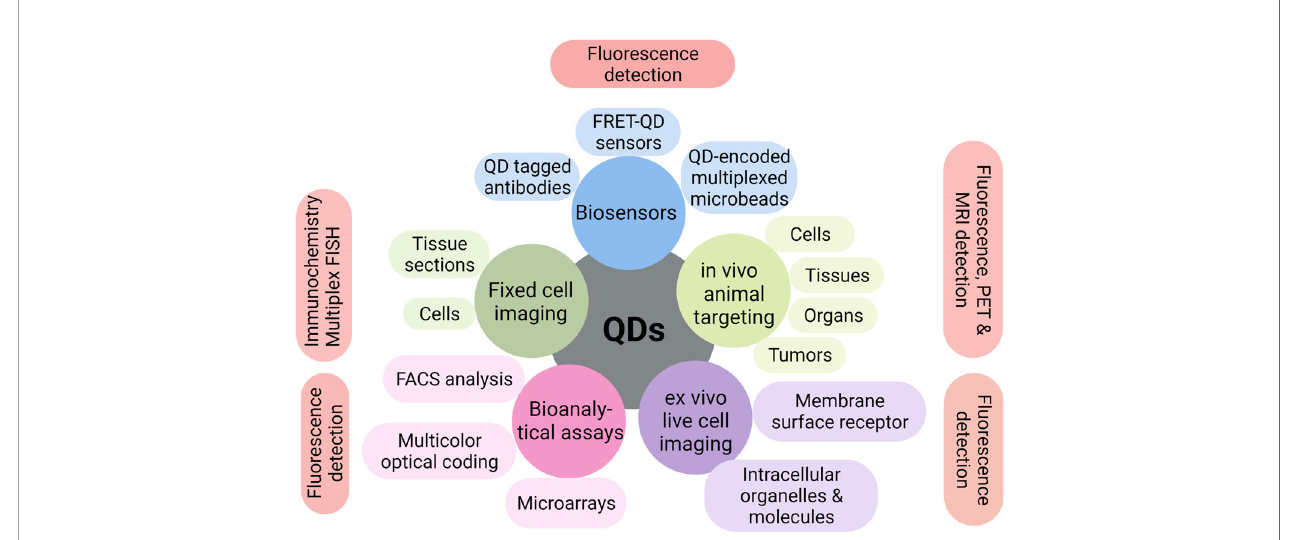
FIGURE 3 | Multiple applications of QDs in biotechnology. QDs have shown excellent multiple applications in biosensors, bioanalytical assays, fi xed or live-cell imaging, and in vitro or in vivo imaging over the past few